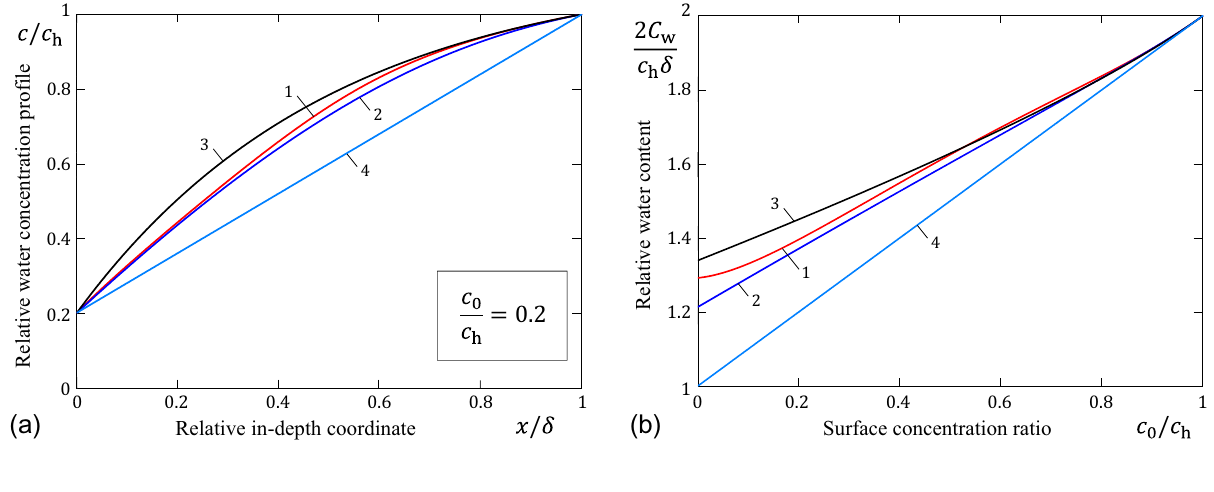
Figure 3. ( a ) Water concentration profile in stratum corneum; ( b ) Water content in stratum corneum. Curves 1, 2, and 3 correspond to formulas (1), (2), and (3), respectively. The straight line (curve 4) represents the constant diffusivity